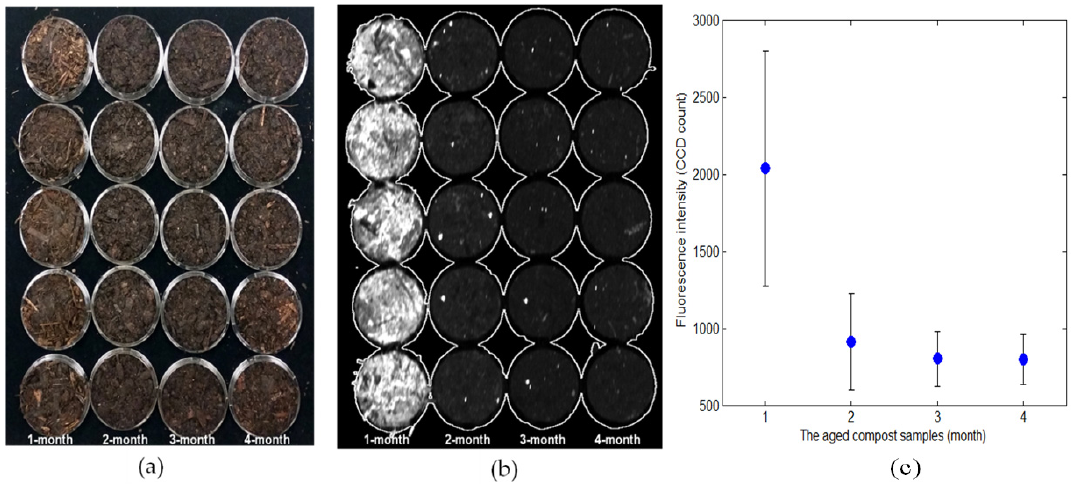
Figure 5. ( a ) Photo of aged compost samples; ( b ) Fluorescence image of the aged compost samples shown in the color photo acquired at 676 nm. The presence of fecal matter (gray-white spots) is evident even after the two-, three-, and four-month composting for the compost samples under investigation. Note that the rest of the samples, sets 2 to 4, exhibited similar responses and were omitted for brevity. The white boundary edges of the sample materials/Petri dishes were added to outline individual samples; ( c ) Mean and standard deviation values for fluorescence intensities at 676 nm.